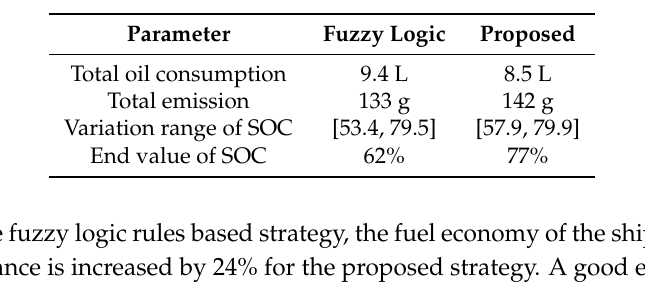
Table 2. Comparison of the two compared strategies’ different performance